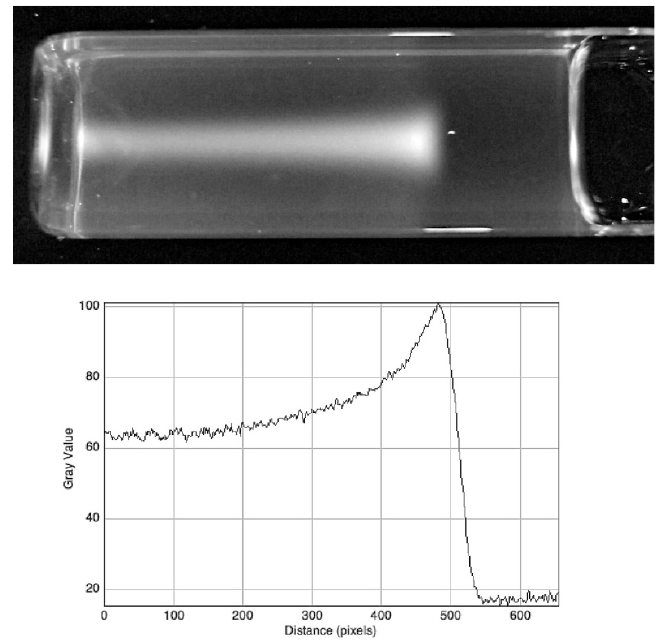
Figure 12. Upper: A grayscale image of an 80 MeV proton beam propagating in an RFG gel. Lower: Figure 12. Upper : A grayscale image of an 80 MeV proton beam propagating in an RFG gel. Lower : A pixel-intensity profile along the axis of the beam; 0.061 mm per pixel. A pixel-intensity profile along the axis of the beam; 0.061 mm per